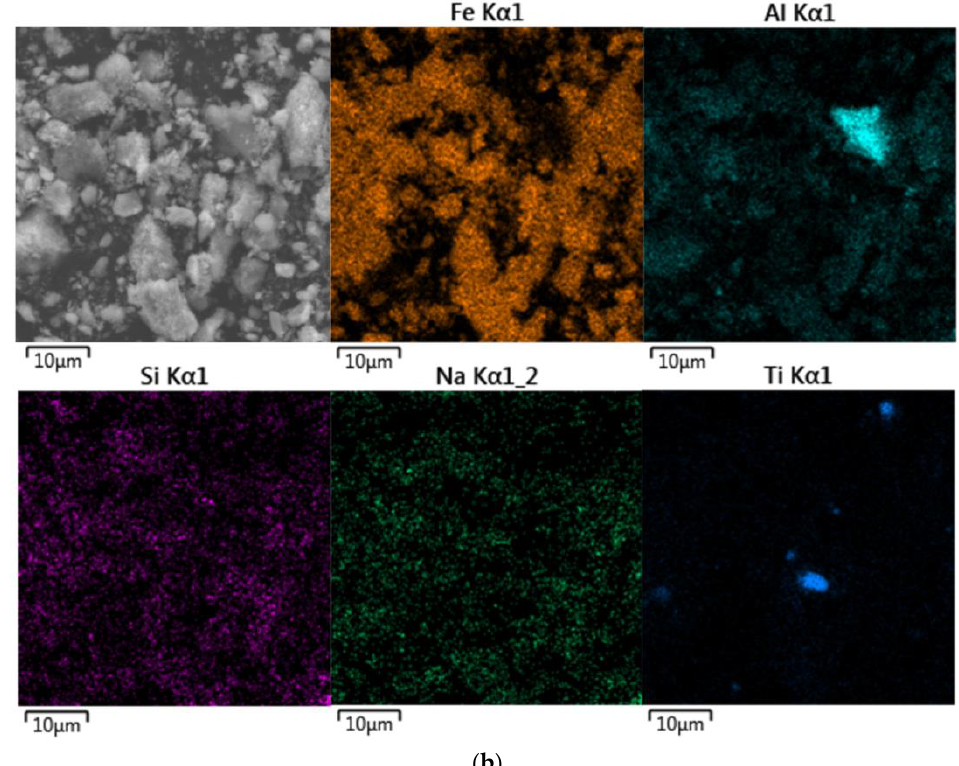
Figure 2. Backscattered electron (BSE) image and elemental mapping of BR particle surface ( a ); BSE images and elemental mapping of the sand particle surface ( b ).